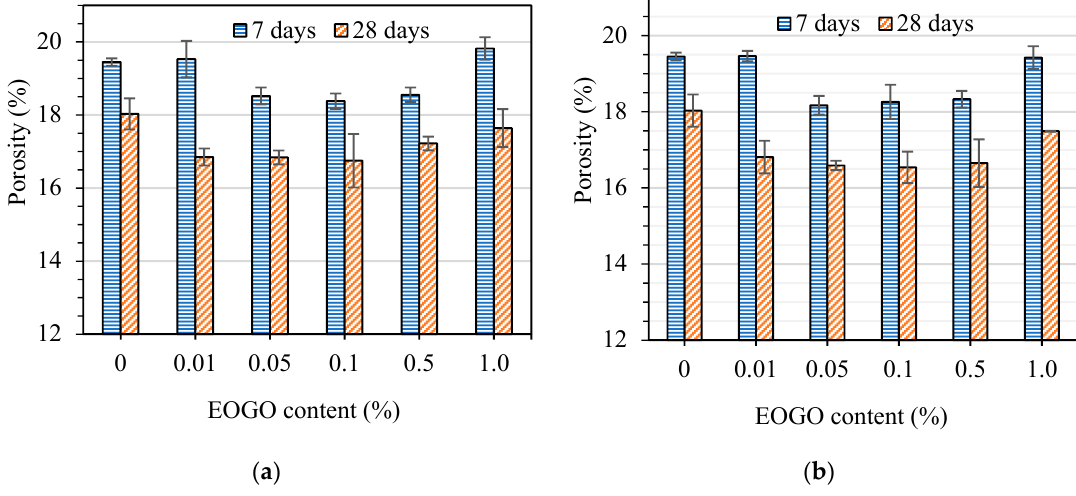
Figure 12. Effect of EOGO on the porosity of mortars: ( a ) Dry-mix design and ( b ) wet-mix design.